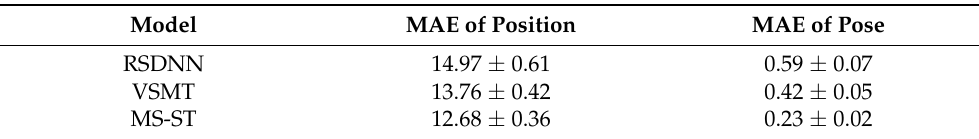
Table 5. Position and pose detection precision comparison among MS-ST, VSMT and RSDNN on the parcel